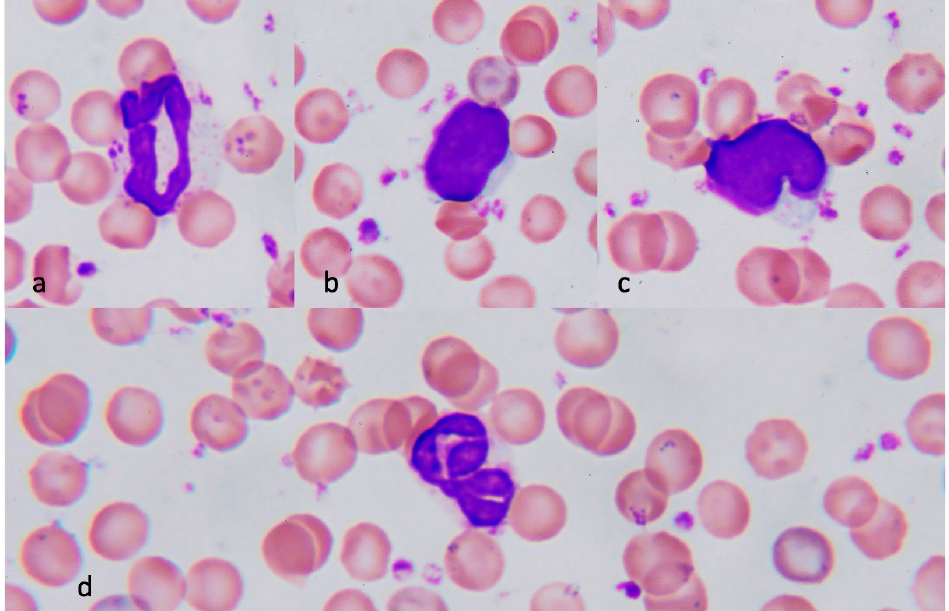
Figure 2. Normal blood cells. Neutrophil shows sausage or donut-shaped nucleus and fine Azur granules in the cytosol ( a ). Lymphocyte has oval ( b ) or notched ( c ) nucleus and small blue-stained cytosol. The nucleus of the neutrophil is sometimes twisted but not hyper-lobulated in normal conditions ( d ). Polychromatophilic erythrocytes are less and platelets are not aggregated.